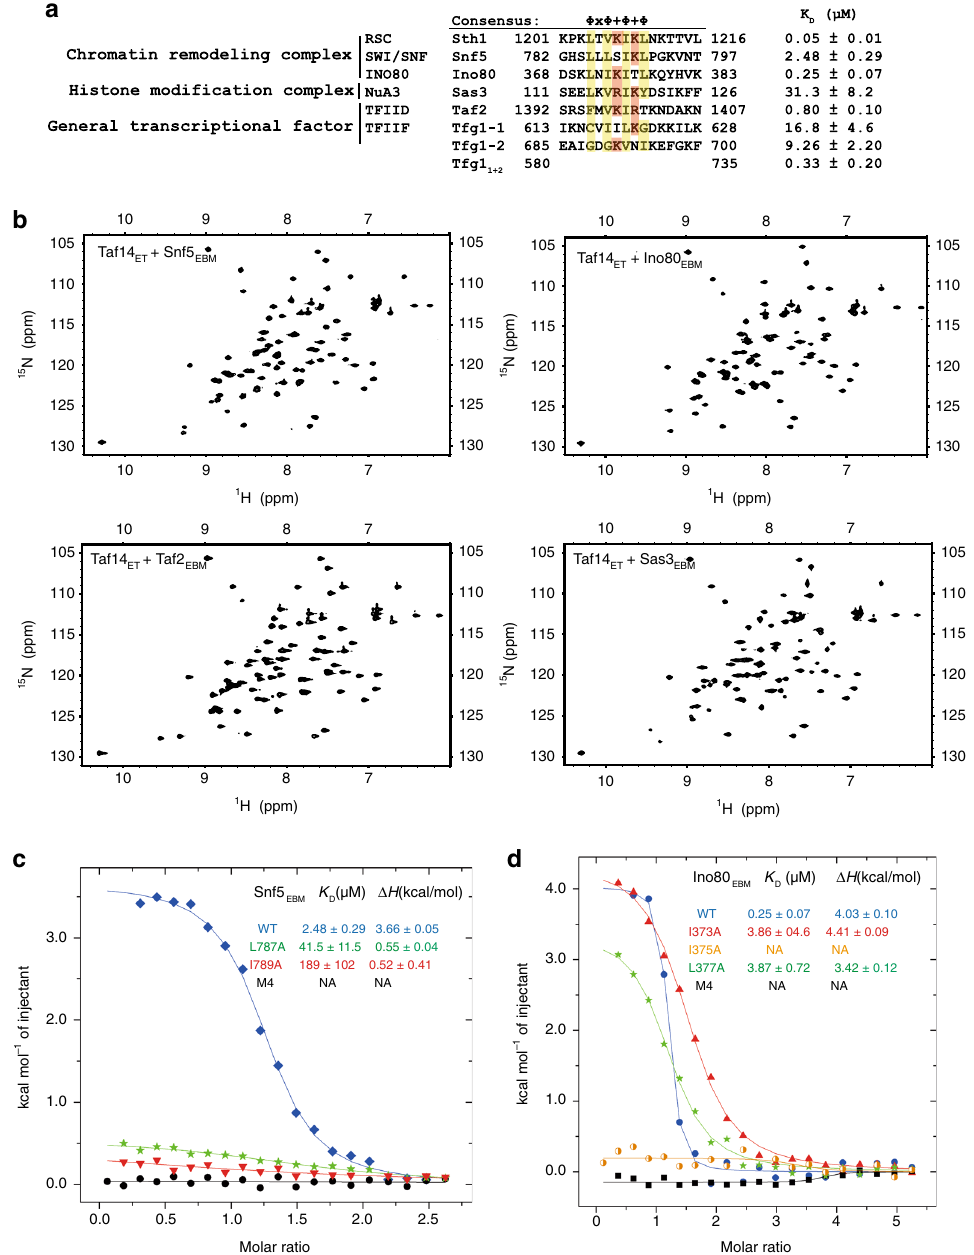
Fig. 4 Taf14 ET recognizes a conserved motif on partner proteins. a Sequence alignments of the Taf14-binding motifs present in the Sth1, Snf5, Ino80, Taf2, Sas3, and Tfg1 proteins. The consensus sequence is Φ × Φ + Φ + Φ , where Φ stands for hydrophobic residues, + stands for a positively charged residue, and × stands for any amino acid. The dissociation constants determined by ITC assays were shown. b [ 15 N- 1 H] HSQC of Taf14 ET (1 mM) in the presence of unlabeled Snf5 771 – 800 , Ino80 368 – 390 , Sas3 111 – 129 , and Taf2 1393 – 1406 (1.5 mM). They all show similar chemical shift patterns that initially observed for the Taf14 ET – Sth1 EBM complex. c ITC measurements reveal that mutations in hydrophobic residues of the Snf5 binding motif weaken the Taf14 ET – Snf5 EBM interaction. M4 stands for the Snf5 L785A/L787A/I789A/L791A mutation. The dissociation constant ( K D ), enthalpy change ( Δ H ), and their fi tting errors from one ITC plot were shown. d ITC measurements reveal that mutations in hydrophobic residues of the Ino80 binding motif weaken the Taf14 ET – Ino80 EBM interaction. M4 stands for the Ino80 L371A/I373A/I375A/L377A